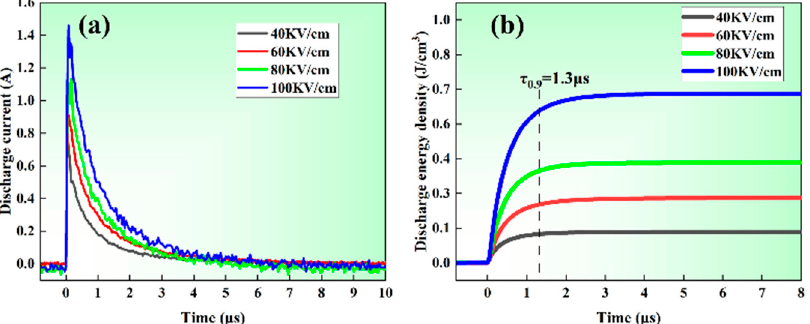
Figure 7. The discharge behavior of the 0.05BF-0.35BMT-0.6BT bulk ceramics at different E : ( a ) the pulsed I with discharge time t and ( b ) the W rec with discharge time t .